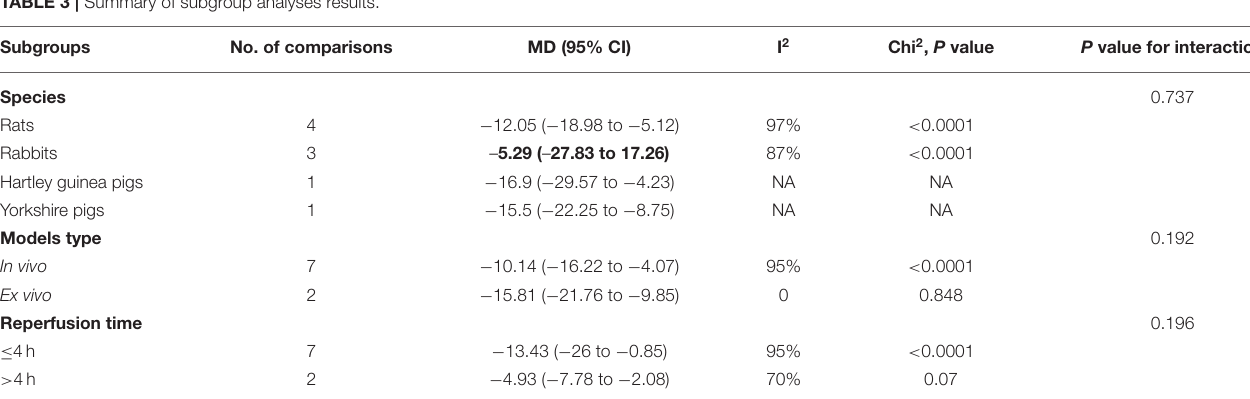
TABLE 3 | Summary of subgroup analyses results.